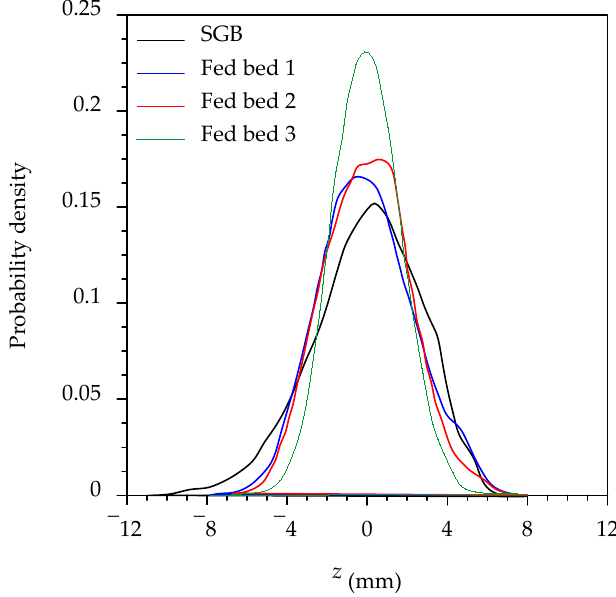
Figure 3. Probability density functions of bed surface fluctuations with respect to the mean surface level in WGBs (namely, Fed bed 1, Fed bed 2, and Fed bed 3) and an SGB (data extracted from Cooper and Tait [12]).